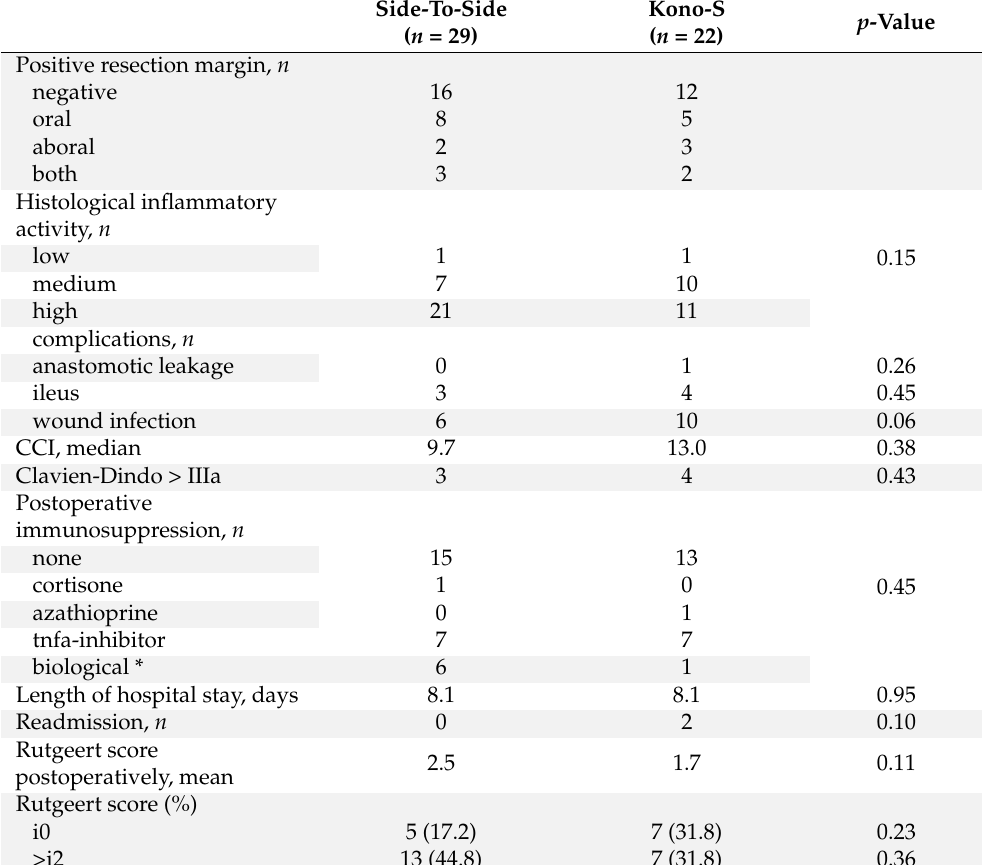
Table 2. Histopathological analysis and postoperative